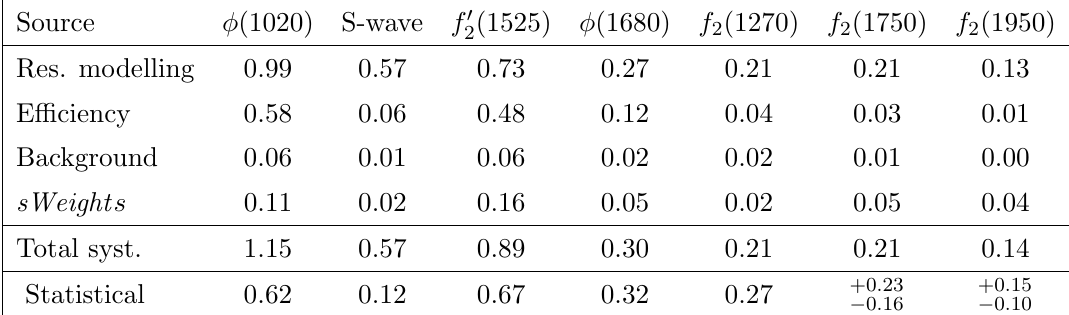
Table 6 . Combined systematic and statistical uncertainties in the (cid:12)t fractions using an absolute scale where the numbers are in units of %. \Res. modelling" refers to resonance